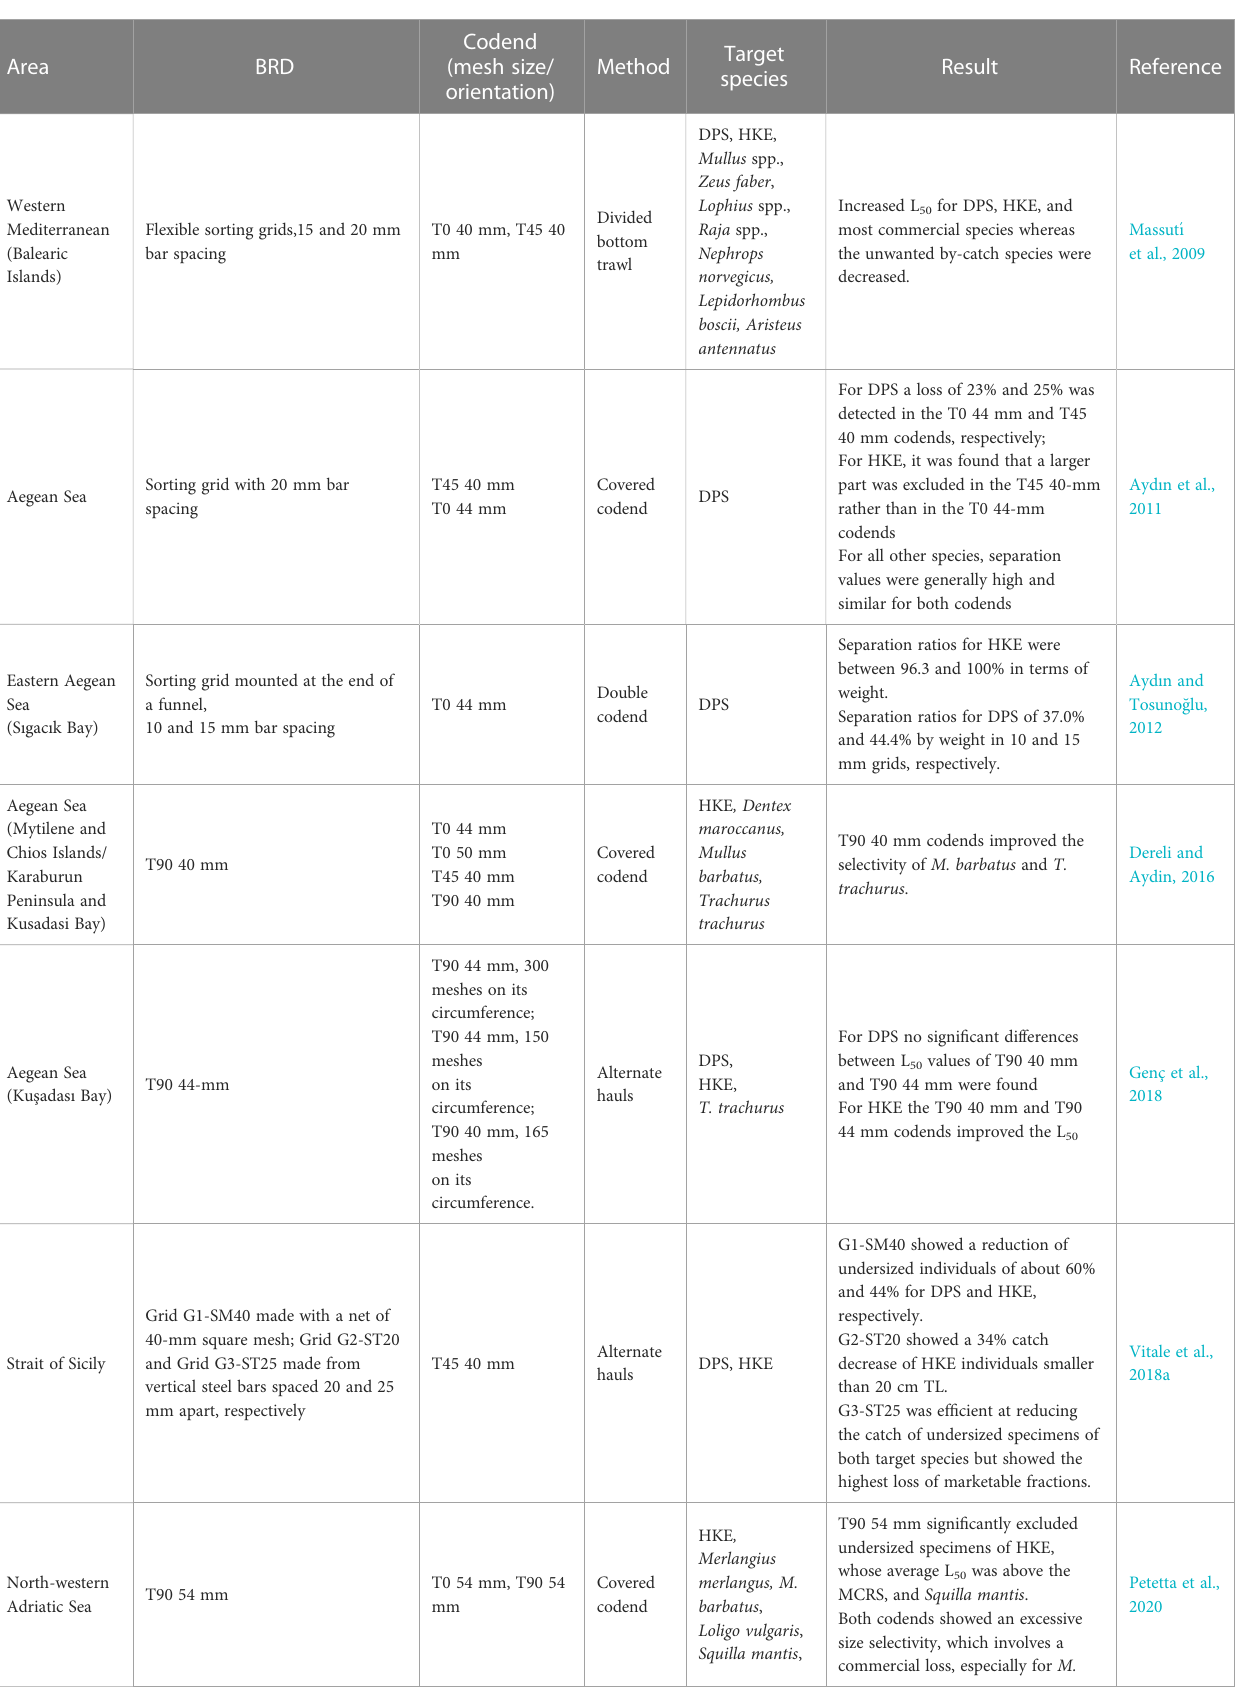
TABLE 5 Results of research in the Mediterranean Sea during which the sorting grid or T90 mesh was